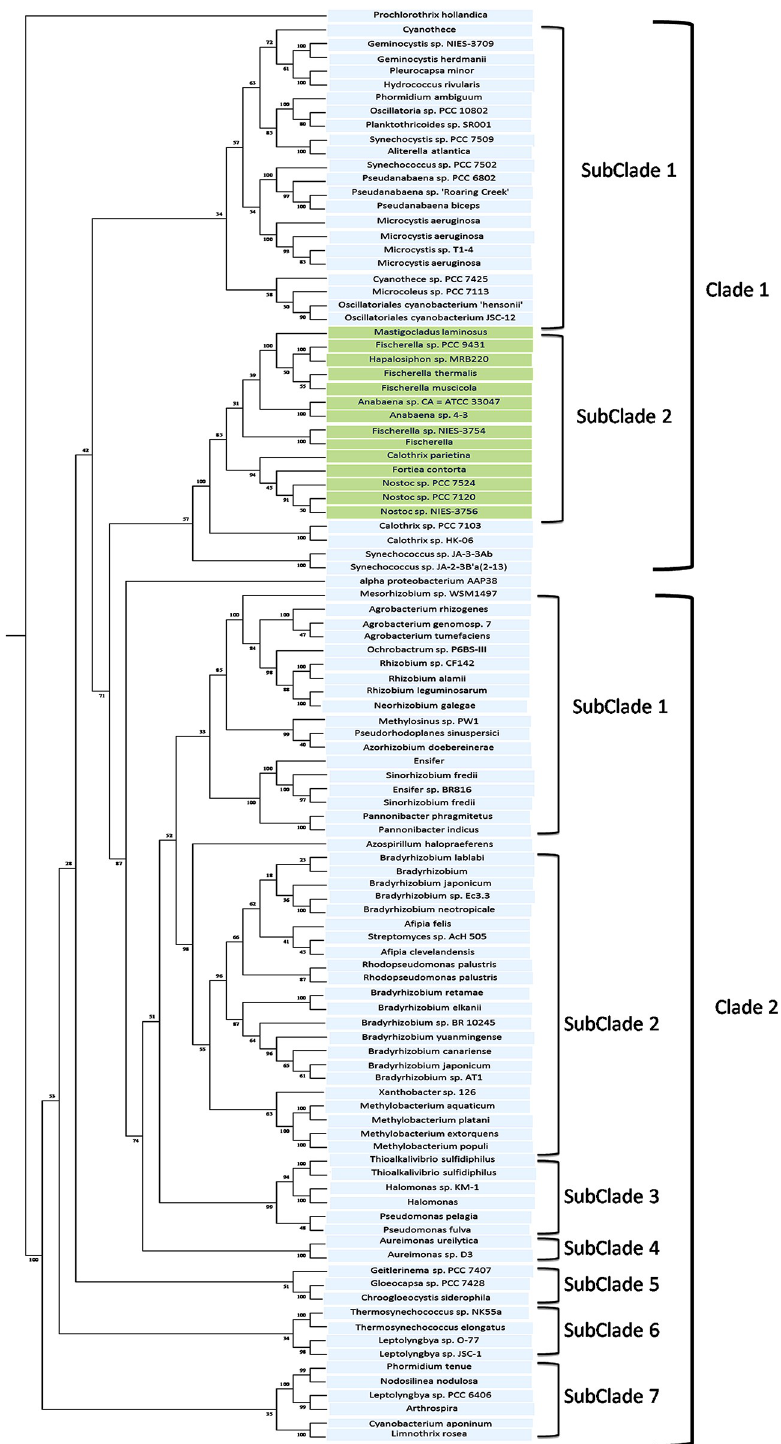
Fig 3. Phylogenetic tree of deduced nrtA protein. The tree was constructed by PHYLIP programs using Seqboot, Protdist, Neighbour and Consense methods. Bootstraping (1000 times) was performed to obtain support values for each branch. Values are shown at the nodes of each branch